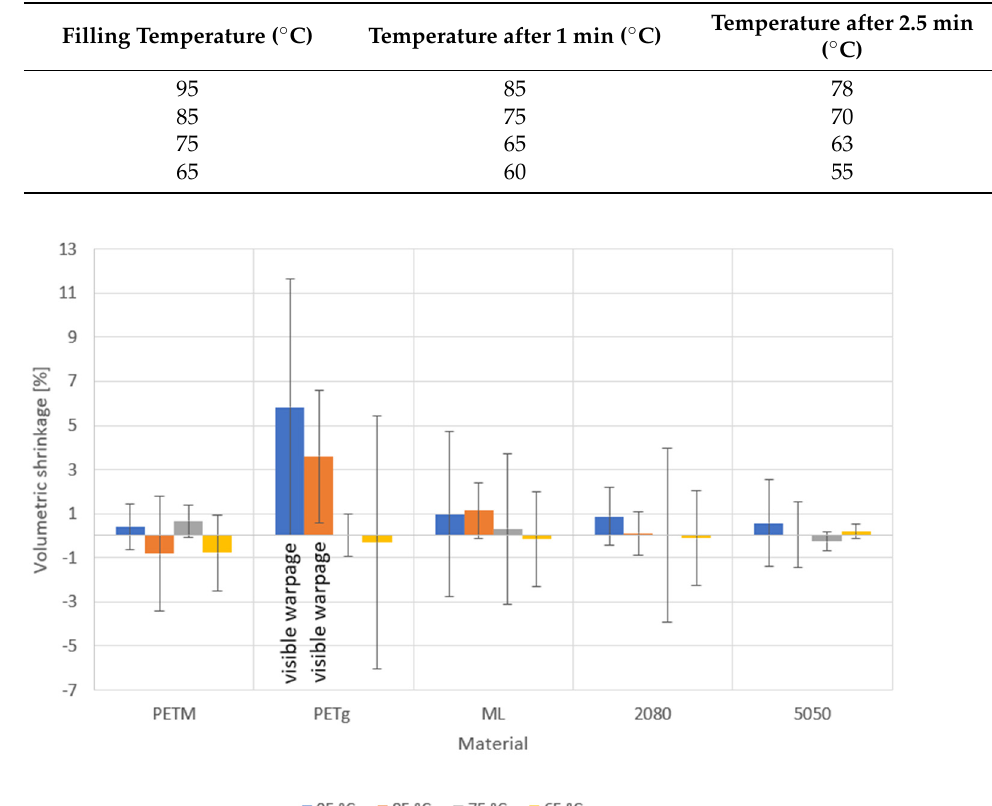
Figure 12. Volumetric shrinkage of the trays from different materials (Table 2) after hot filling for the different initial hot-fill temperatures. The 95% confidence interval of the volumetric shrinkage is given by the error bars.